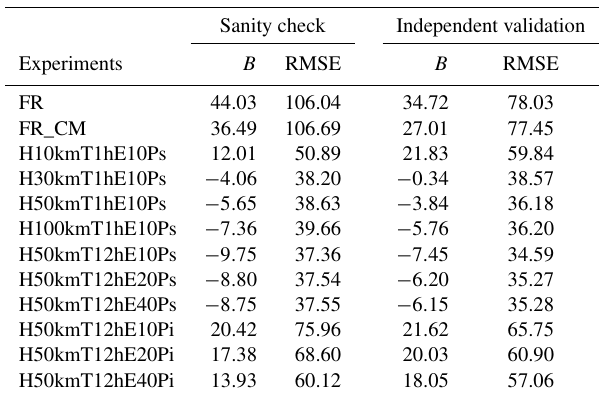
Table 2. The mean biases and root mean square errors (RMSEs) of the simulated SO 2 surface concentrations in various experiments and the CNEMC-observed ones over all assimilated and indepen- dent